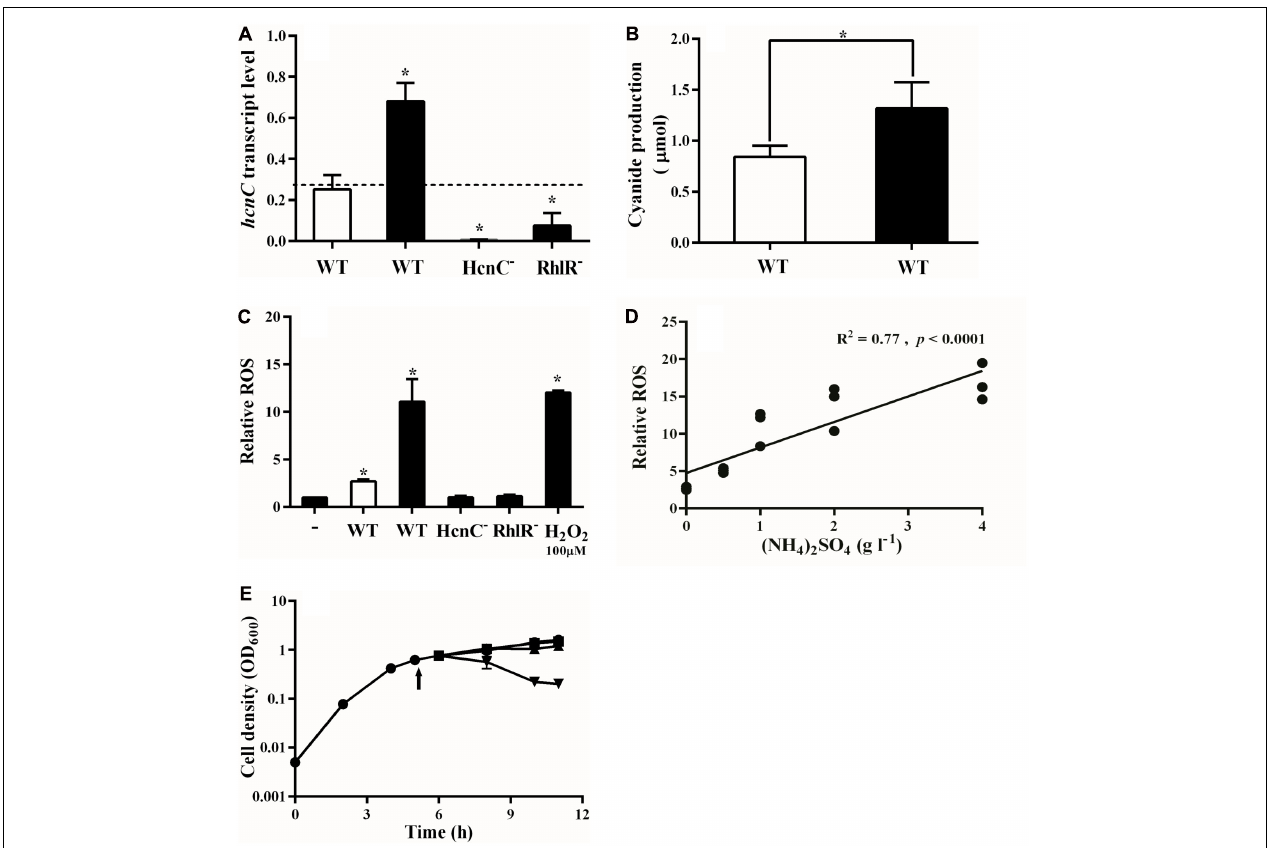
FIGURE 3 | Ammonia promotes cyanide and ROS production by cooperators. (A) hcnC transcription in w.t. increases in presence of LasR-mutant cheaters in PM-casein with ammonium. hcnC expression from either a RhlR or HcnC deletion mutant in co-culture with the LasR mutant is shown as controls. proC was used as reference gene. In panels A–C , white bars indicate media without ammonium sulfate and black bars indicate that ammonium sulfate was added. (B) Cyanide production by cooperators in PM-casein with or without ammonium sulfate. (C) ROS production from LasR mutants in LB-MOPS, combined with supernatants of strains grown in PM-casein media. “ − ” indicates no cells. (D) ROS production by the w.t. increases as the concentration of ammonium sulfate is increased. (E) Growth inhibition of the LasR mutant by supernatant from w.t.:LasR-mutant co-culture from PM-casein with ammonia media (inverted triangle). The supernatant from a w.t.:LasR-mutant co-culture in PM-casein media (triangle) did not inhibit the growth of LasR mutants; neither did supernatant from a HcnC-mutant: LasR-mutant co-culture (square). The arrow indicates the time of supernatant addition. Experiments were performed in triplicate. ∗ indicates p < 0.05 by paired Student’s t -tests (panels A–C and E ). A linear regression analysis was performed for the data presented in panel D